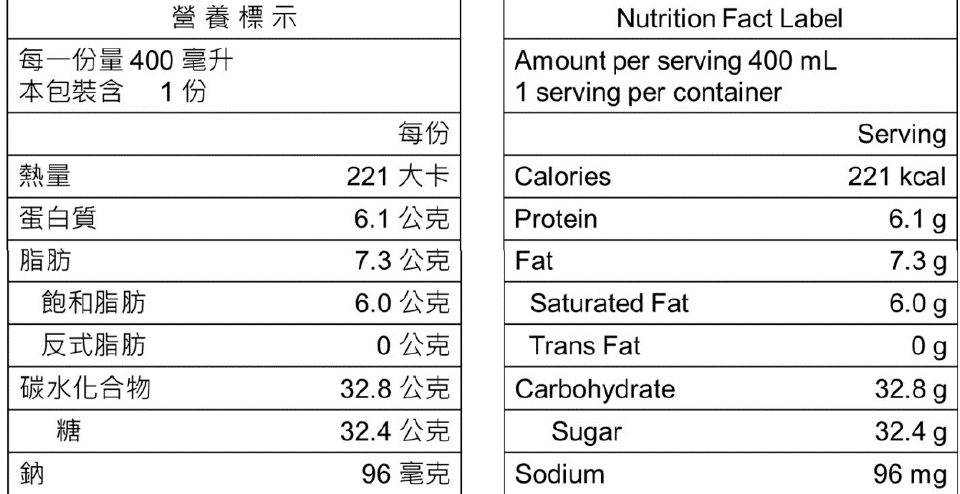
Figure 1. Nutrition fact labels in Traditional Chinese ( left ) and English ( right